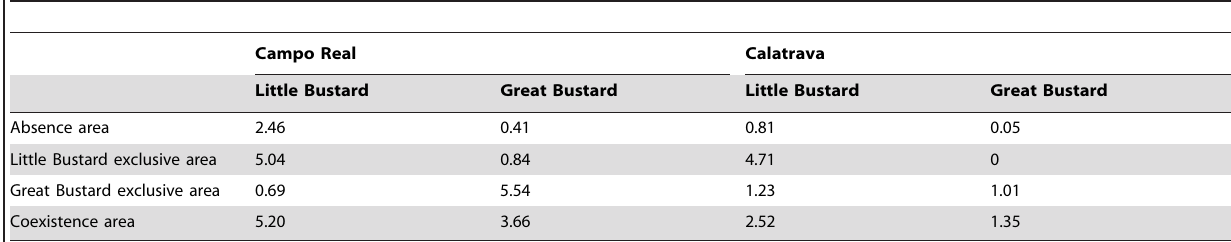
Table 3. Densities of Little (males/km 2 ) and Great Bustards (individuals/km 2 ) in the different area types generated by superimposing the predicted presence maps of Little and Great Bustards for 2011 in Campo Real and 2008 in Calatrava.